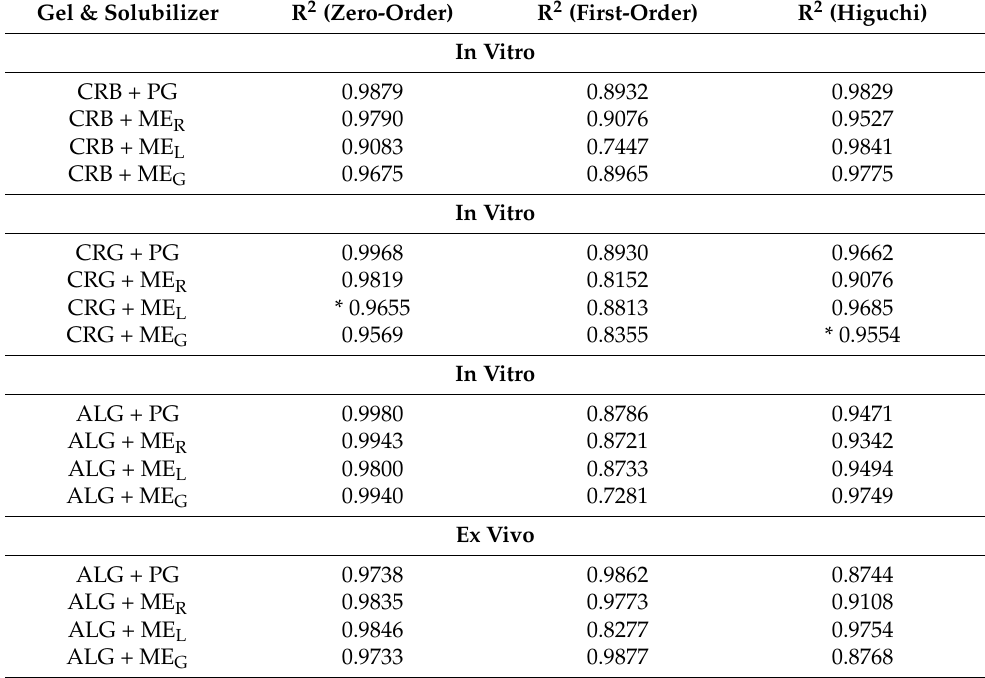
Table 5. The Coefficients of Determination (R 2 ) for the Drug Release Kinetics. Gel & Solubilizer